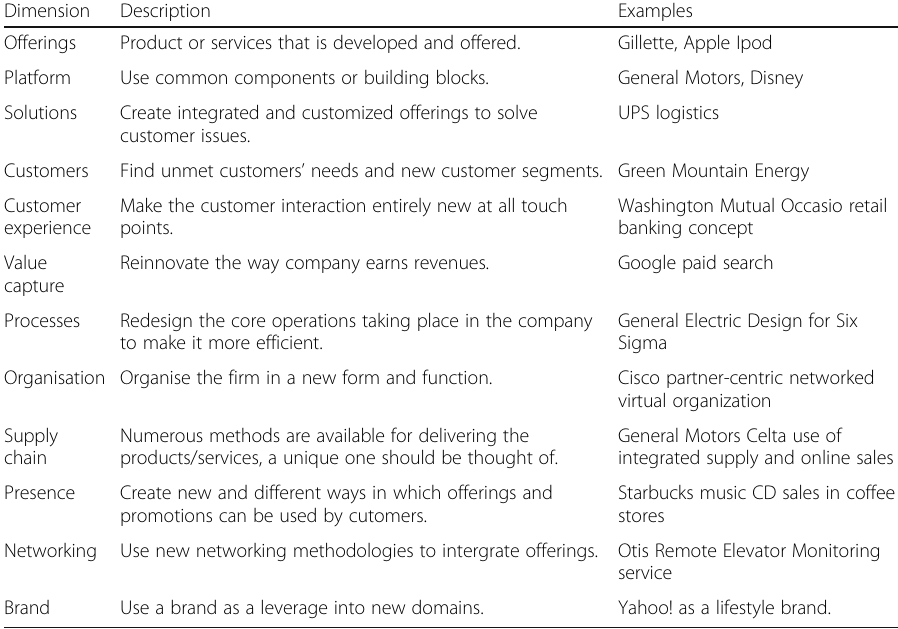
Table 2 Dimensions of innovation radar. Source (Vikas, 2012a, Täuscher, 2016, 2017, 2018, Ghezzi et al., 2018 , Van Dijck et al., 2018)